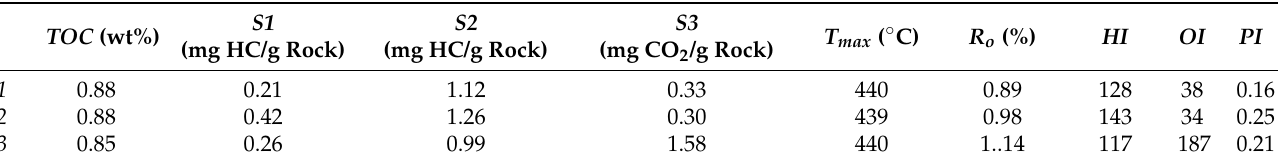
Table 2. Programmed pyrolysis results for samples acquired from a well located in the Cranfield field (USGS).